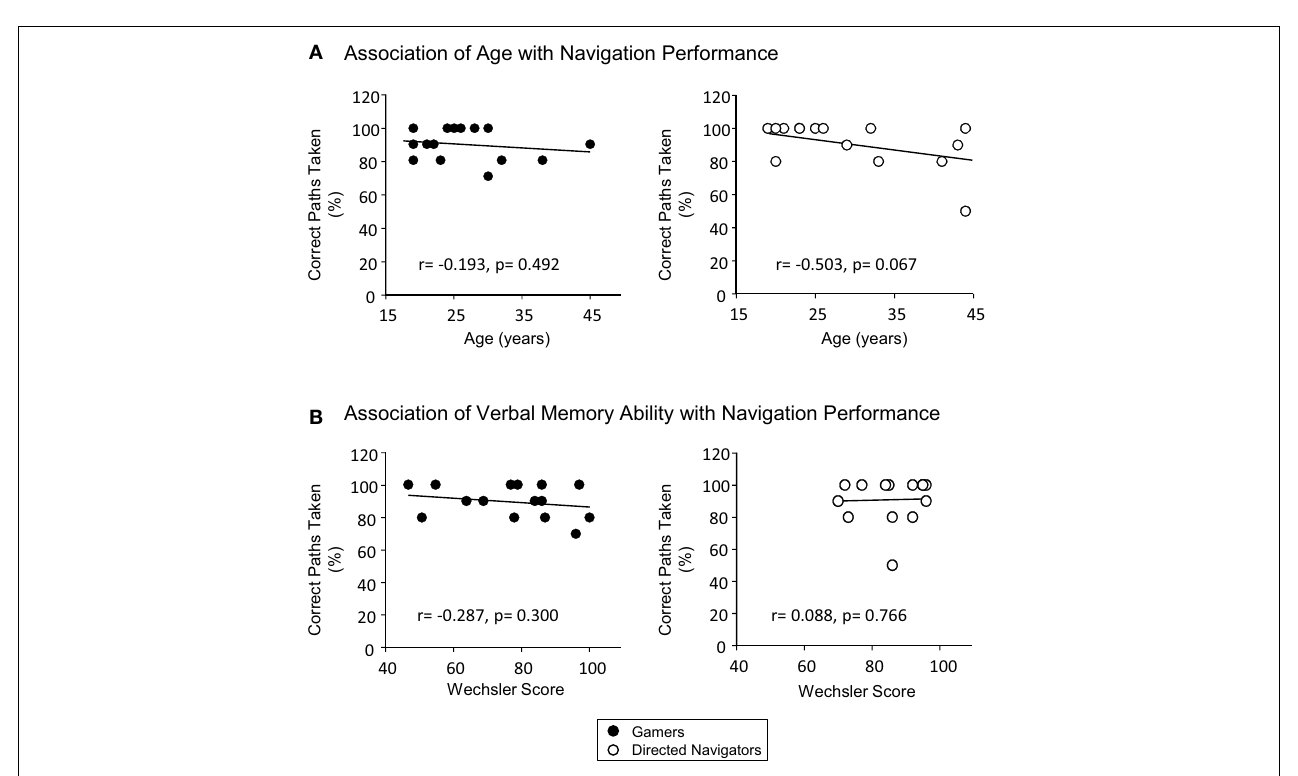
FIGURE 5 | Correlations between navigation task performance (% correct on physical navigation) and factors of interest (A) age and (B) verbal memory ability. No significant associations were observed (data from gamers and directed navigators collapsed).